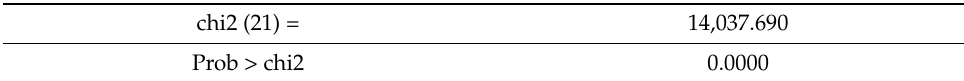
Table A9. Breusch–Pagan test of independence.